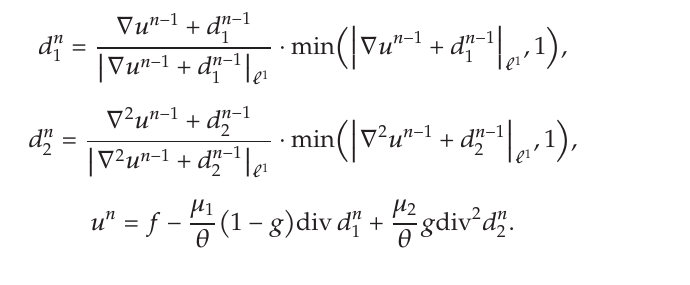
(cid:7) 0 ∈ S , d 0 (cid:7) 0 ∈ Z and u 0 (cid:7) f 2 1